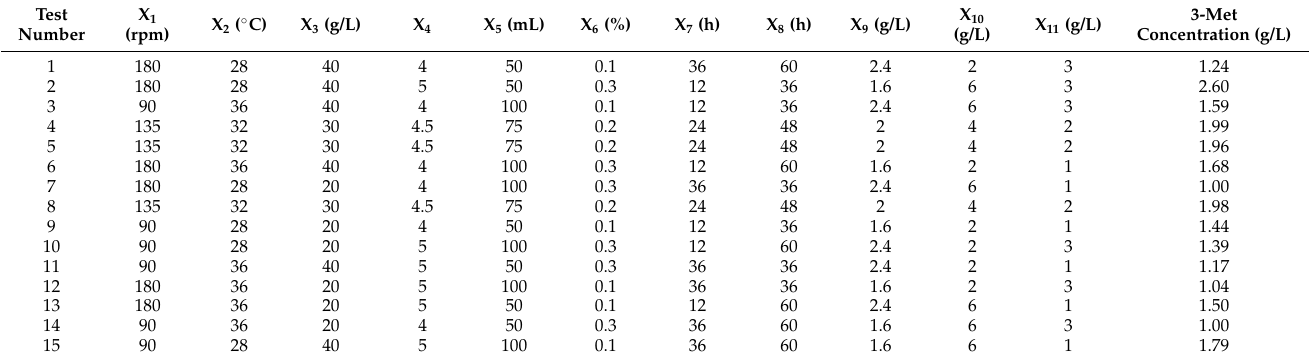
Table 6. PB design matrix for evaluating factors influencing 3-Met